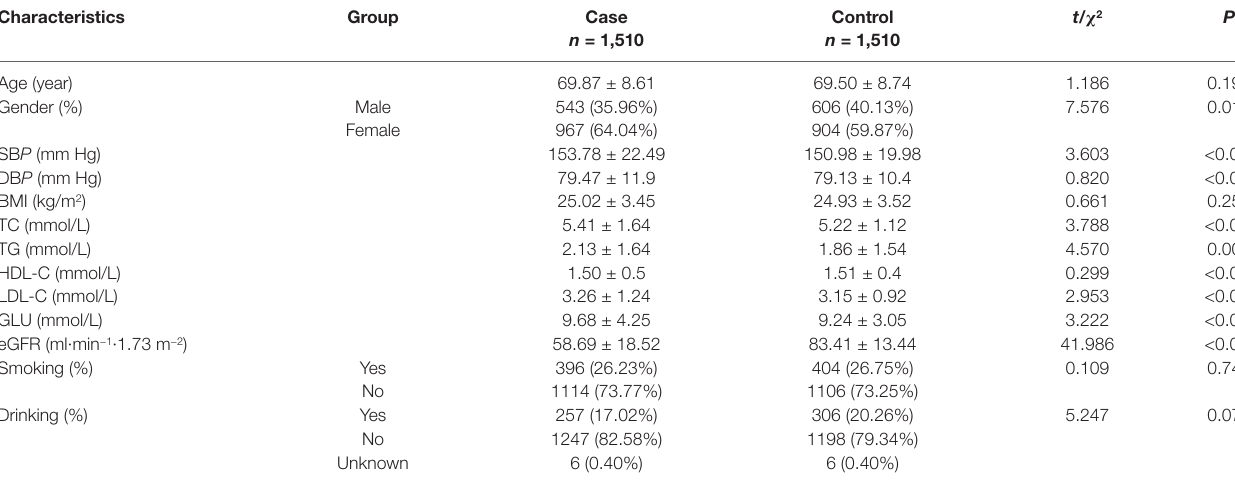
TABLE 1 | Demographic and clinical characteristics of DKD cases and controls.